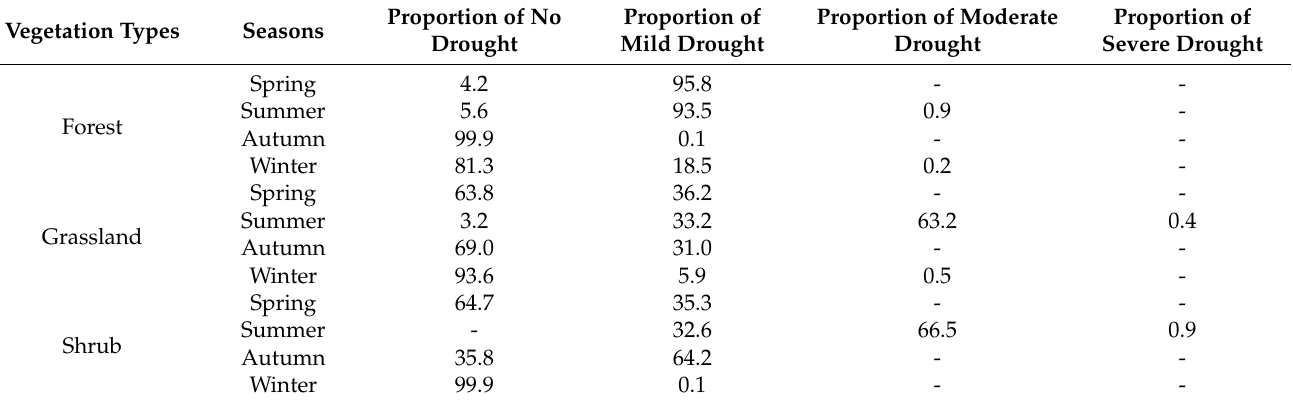
Table A1. Percentage of the area of different vegetation types with drought magnitude in each season (%).